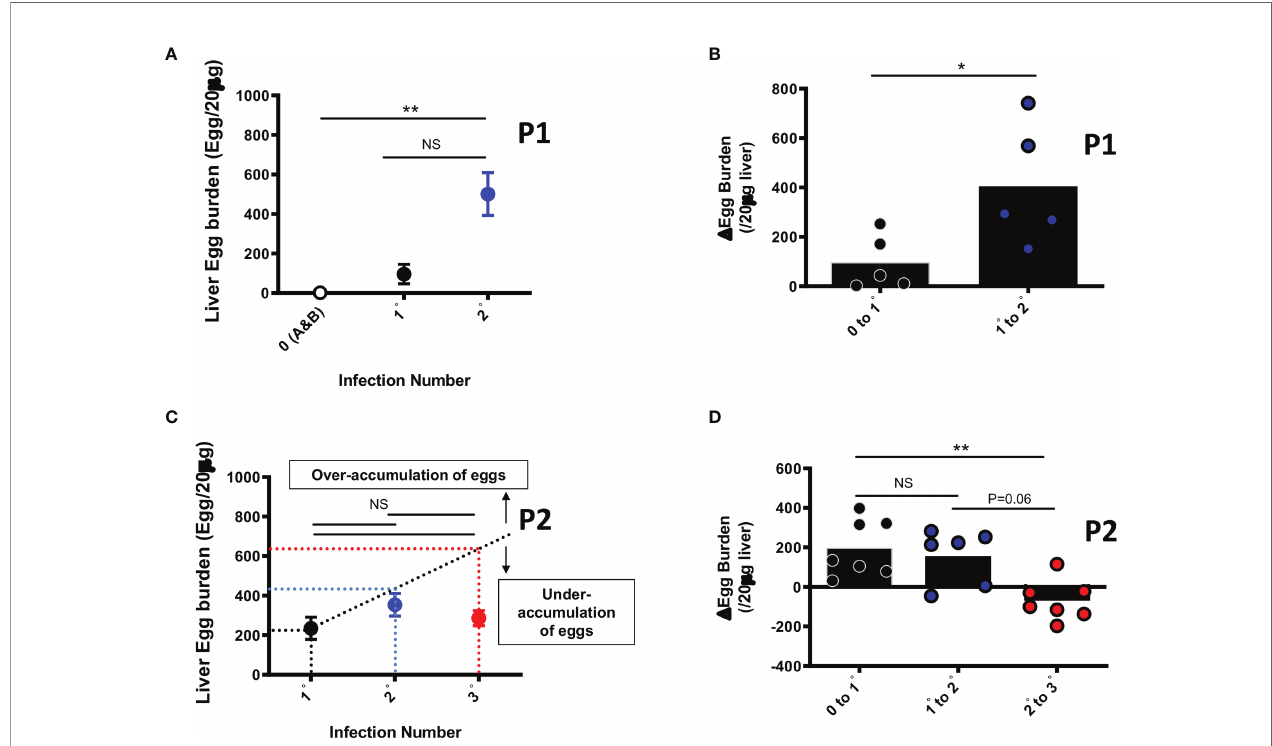
FIGURE 2 | Liver Egg burdens after repeated cycles of S. mansoni infection and PZQ treatments. Outcome measure = Egg accumulation rate in liver (A) Liver Egg burdens are displayed for mice after fi rst (1°) and second (2°) infection cycle with 35 S. mansoni cercariae and analysed at week 15 i.e. P1. (B) Liver egg burden changes in animals undergoing their fi rst (0 to 1°) or second (1° to 2°) cycle of infection intercalated by PZQ treatment rounds and analysed at week 15 i.e. P1 (C) Liver Egg burdens are displayed for mice after fi rst (1°), second (2°) and third (3°) infection cycle with 35 S. mansoni cercariae after 25 weeks i.e. P2. PZQ treatment was administered daily at 400mg/kg by oral gavage twice at the end of each infection cycle of 6-8 weeks. The interrupted line represents the linear prediction of tissue egg burden after repeated infection hypothetically similar in susceptibility as infection 1°. (D) Liver egg burden changes in animals undergoing their fi rst (0 to 1°), second (1° to 2°) or third (2° to 3°) cycle of infection intercalated by PZQ treatment rounds at week 25 i.e. P2. Data shown are means ± SEM from one of 2 experiments, with 4-7 mice per group in each experiment. NS = p > 0.05; * = p < 0.05; ** = p < 0.01 as determined by Kruskal-Wallis test with correction for multiple comparisons by Dunn ’ s test (A, C, D) or by two-tailed Mann Whitney U test (B)